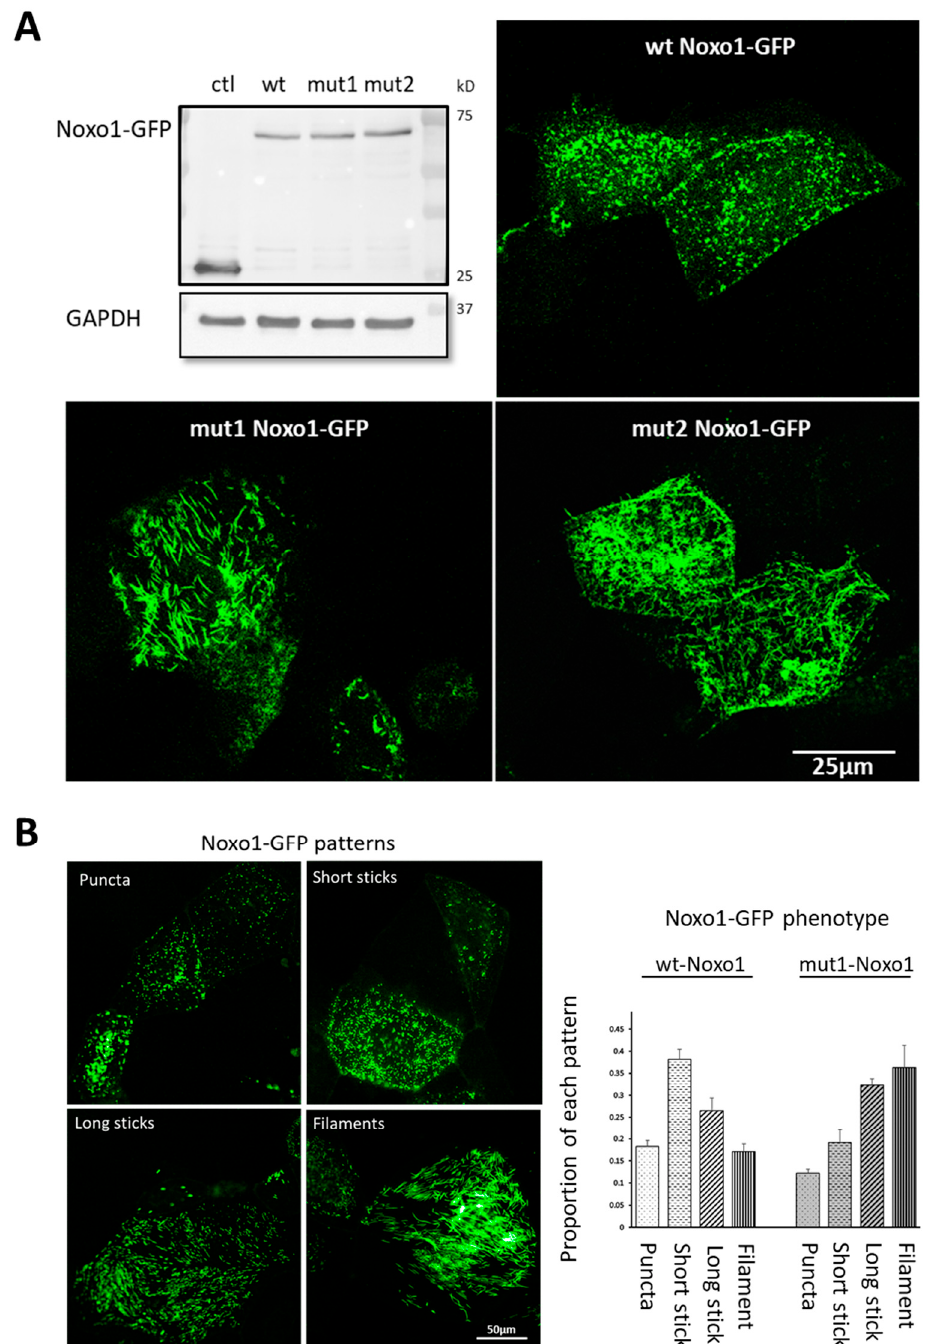
Figure 2. Effects of the overexpression of Noxo1-GFP on the pattern of Noxo1 in Caco-2 cells. ( A , upper left ) Immunoblot of control GFP (ctl), wt Noxo1-GFP, mut1-GFP, and mut2-GFP overexpression. GAPDH was used as the loading control. The ctl corresponds to transfection with the GFP vector. ( A , upper right and lower panels ) Immunofluorescence images for GFP overexpressing wt Noxo1-GFP, mut1 Noxo1-GFP, or mut2 Noxo1-GFP, respectively. Confocal immunofluorescence imaging projections show that the wt Noxo1-GFP displays a punctate pattern while mutants exhibited a more filamentous pattern. In all panels, scale bar: 25 µ m. ( B , left ) illustrate different Noxo1-GFP patterns, including puncta, short sticks, long sticks, and filaments. Scale bar in all panels: 50 µ m. ( B , right ) quantitative analysis of each pattern in both wt Noxo1-GFP and mut1 Noxo1-GFP obtained using HCS Operatta. Scale bar: 50 µm.